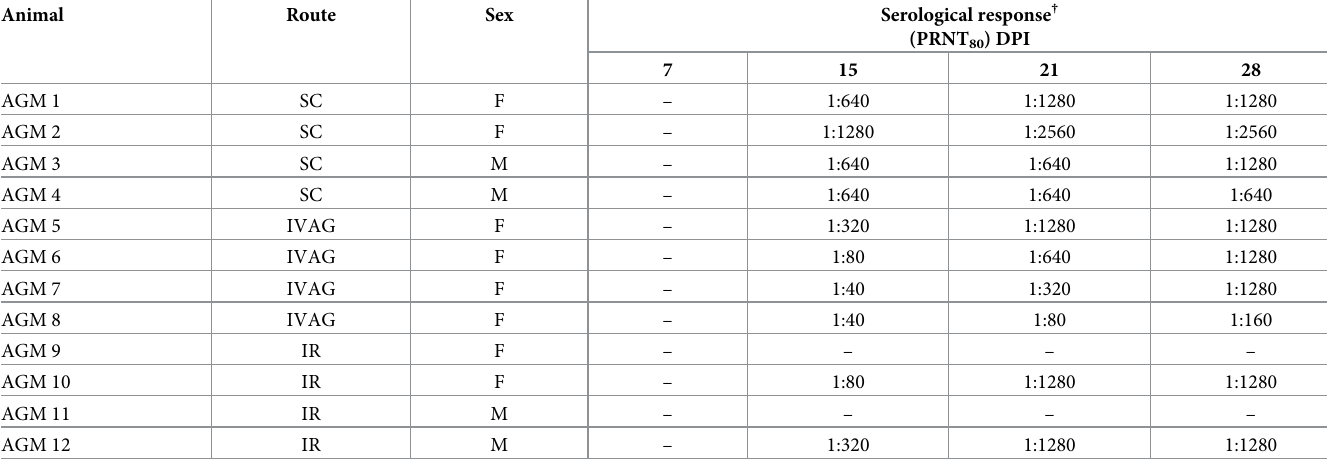
DPI, Day post-inoculation. Route: SC, subcutaneous; IVAG, intravaginal; IR, intrarectal. – < 1:20. � Limit of detection 1.0 log 10 PFU/mL. † Limit of detection